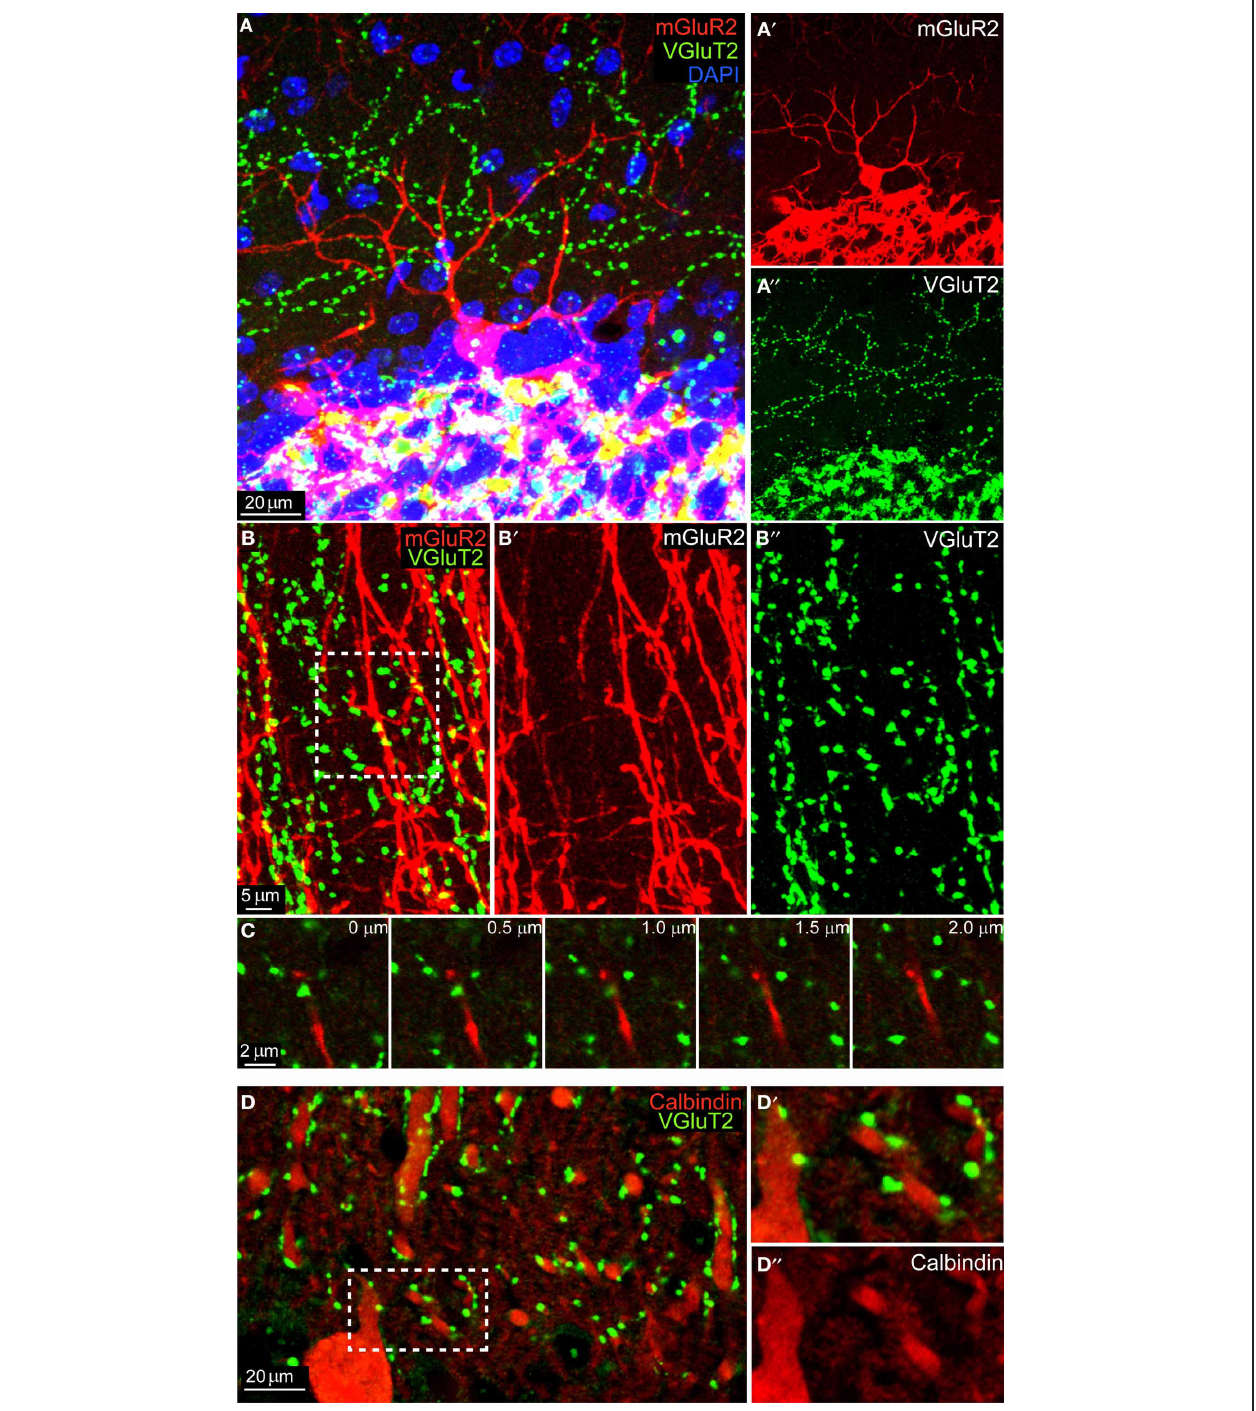
FIGURE 1 | No colocalization between mGluR2-marked GoC and VGlut2 in the ML. (A) Maximum intensity projection of a 20 µ m-thick sagittal section of an mGlur2-stained GoC (red) located in the upper GL (identifiable through the extremely dense DAPI staining, in blue). Its dendrite ascends to the ML, where punctuate staining indicates VGlut2. The red and green channels are split and presented separately in, respectively, (A’) and (A”) . Note the mismatch of the two signals. (B) High-magnification of the ML in coronal section (maximum intensity projection of a 2 µ m slices), with red GoC